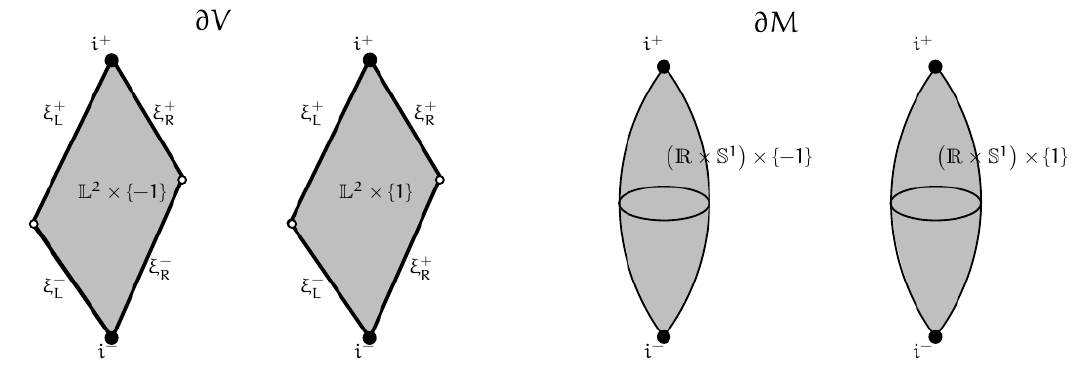
Figure 4 . On the left (cid:12)gure is represented the c-boundary of V , which is formed by two copies of the c-completion of the 2-dimensional Minkowski spacetime glued by the corresponding edges (the identi(cid:12)ed edges are denoted equally). On the right (cid:12)gure it is represented the c-boundary of @M , formed by two copies of R (cid:2) S 1 and the points i + and i - (again identi(cid:12)ed). As the spacetime ( V; g ) is, in fact, a static spacetime, we can calculate directly its c- boundary which structure is given